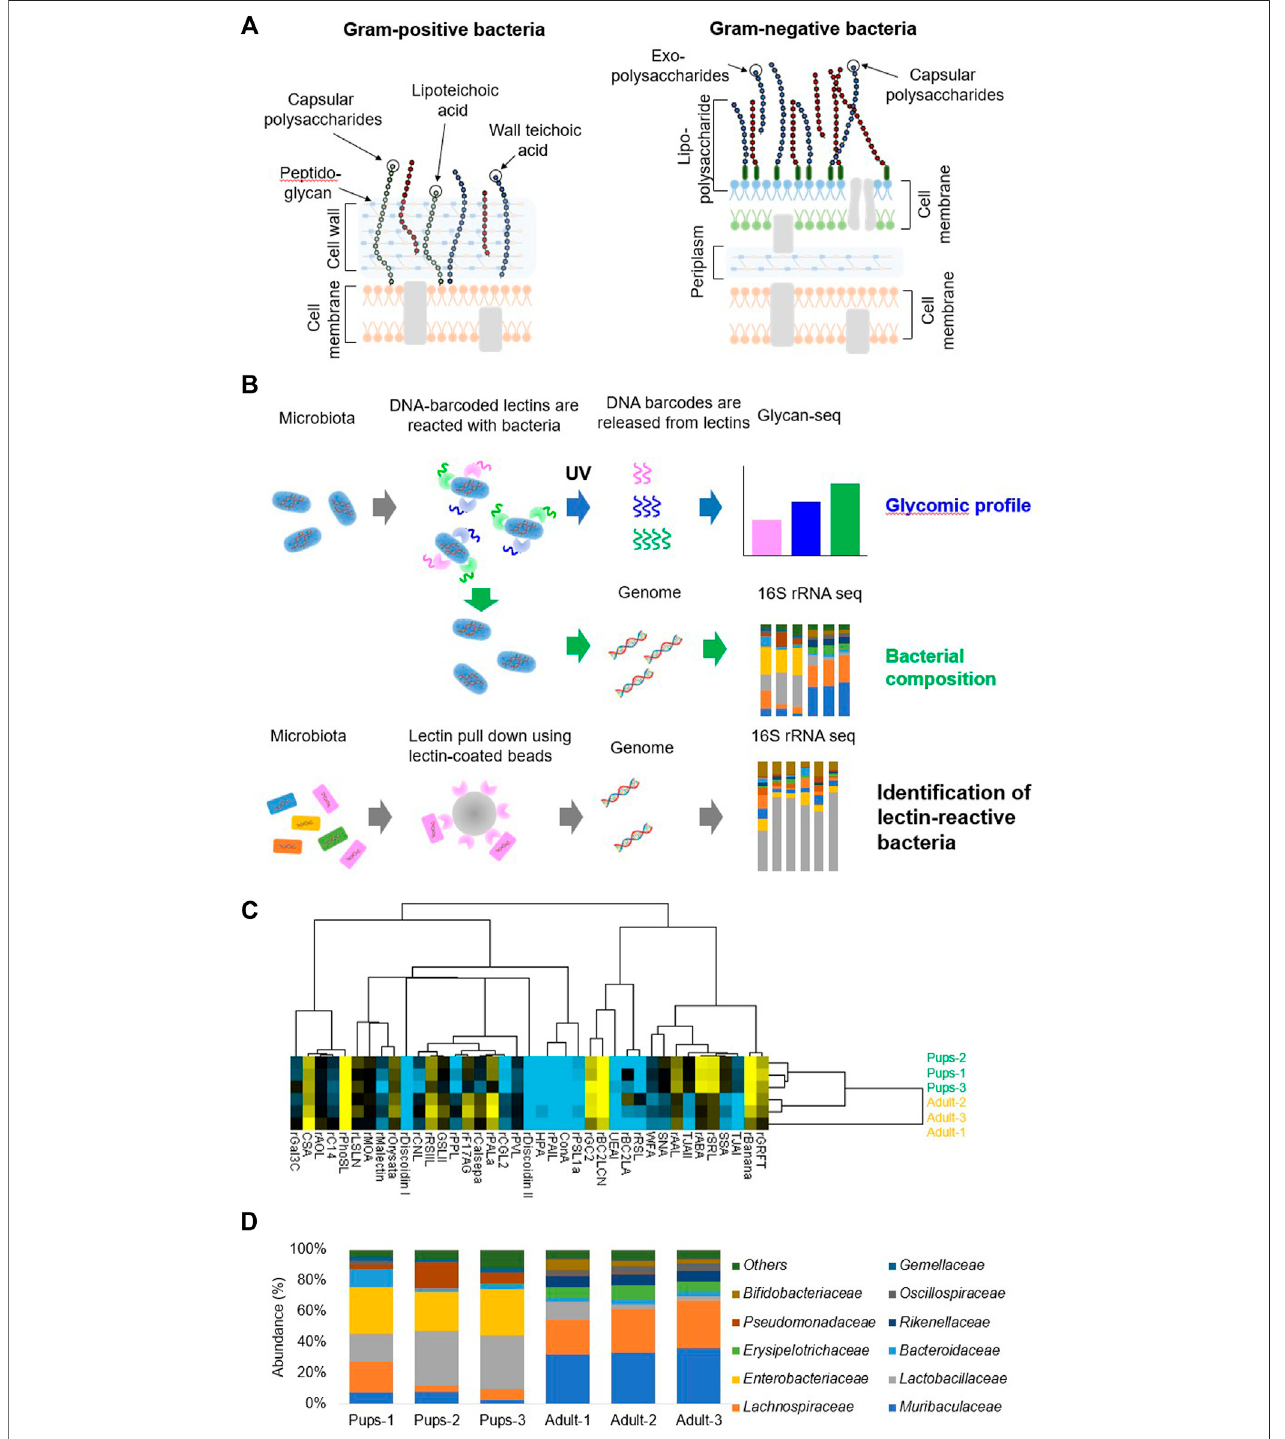
FIGURE 2 | Glycan pro fi ling of the gut microbiota and 16S rRNA sequencing. (A) Illustration of the typical cell wall architecture of Gram-positive and negative bacteria. (B) Schematic experimental work fl ow of glycomic pro fi ling, bacterial composition analysis, and the identi fi cation of lectin-reactive bacteria. (C) Hierarchical clusteringheatmap ofthegut microbiota ofmouse pups (n= 3)and adult mice (n=3) obtained from theGlycan-seqdata.The column shows thepupsand adultmouse sampleseparation, and therow showsthe name ofthe lectins used inthe Glycan-seq analysis. (D) Thestacked bar graph represents the differential abundance of the bacterial family identi fi ed by 16S rRNA sequencing from each sample. Each colored bar represents the bacterial family identi fi ed. Figures are reprinted from Oinam et al. (2022) (Oinam et al., 2022).